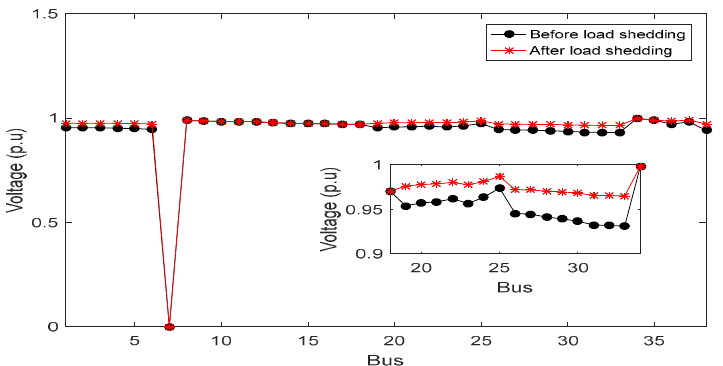
Figure 11. Bus voltages at faulted bus #7 prior to and after load shedding.